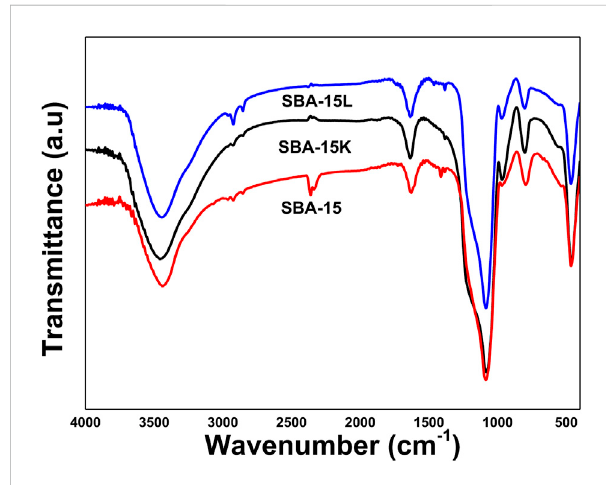
FIGURE 3 SBA-15, SBA@N, and SBA@3N silica ’ s FTIR